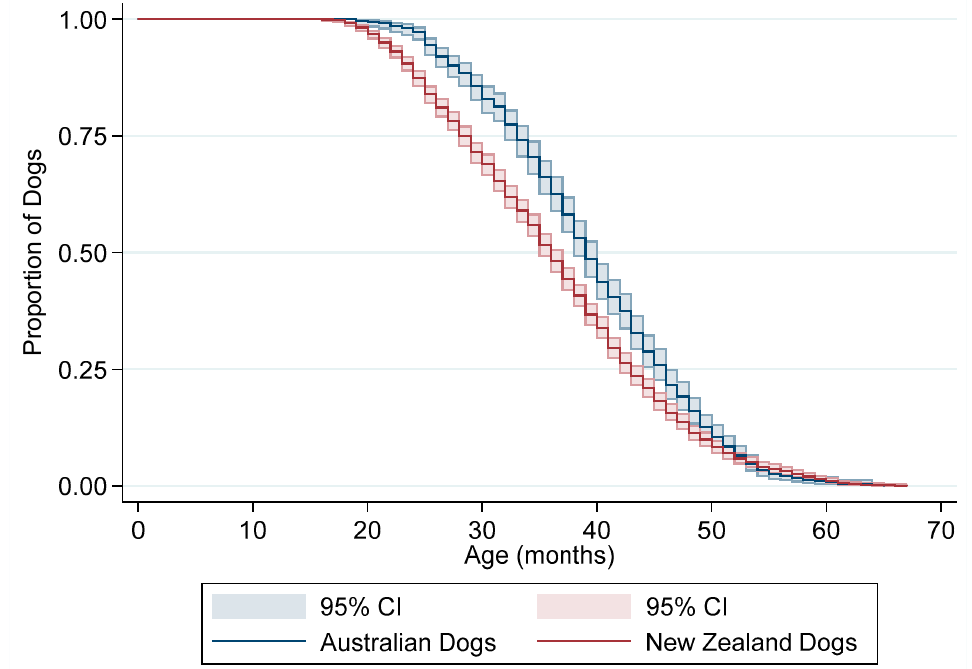
Figure 2. Kaplan–Meier “survival” curve of the age of final racing start (months) stratified by country for a cohort of racing greyhounds in New Zealand. The coloured area around each line represents 95% confidence intervals.